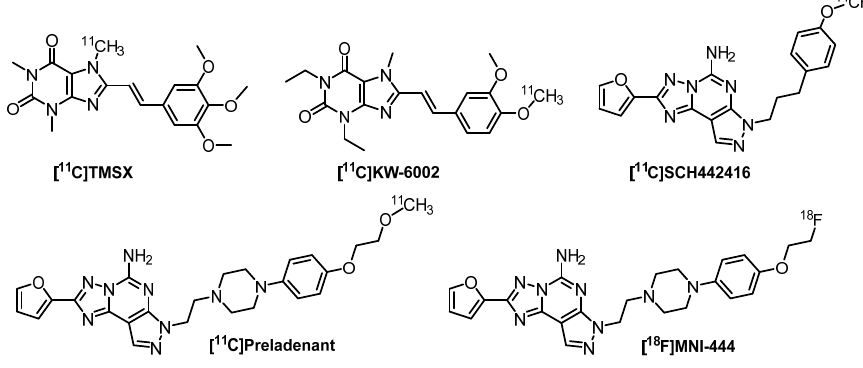
Figure 2. A 2A R PET radiotracers in clinical trials [18] .